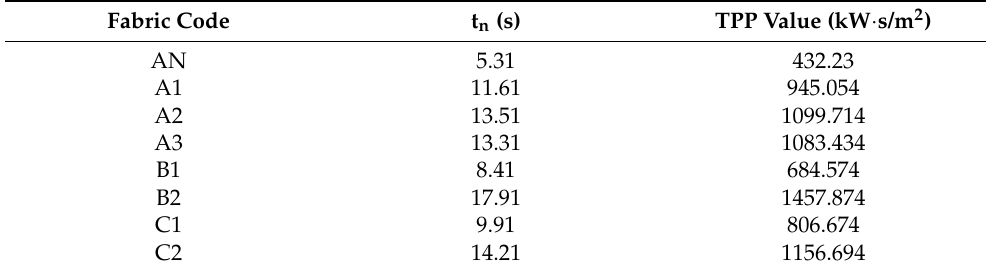
Table 2. TPP value of AN before and after coating treatment.